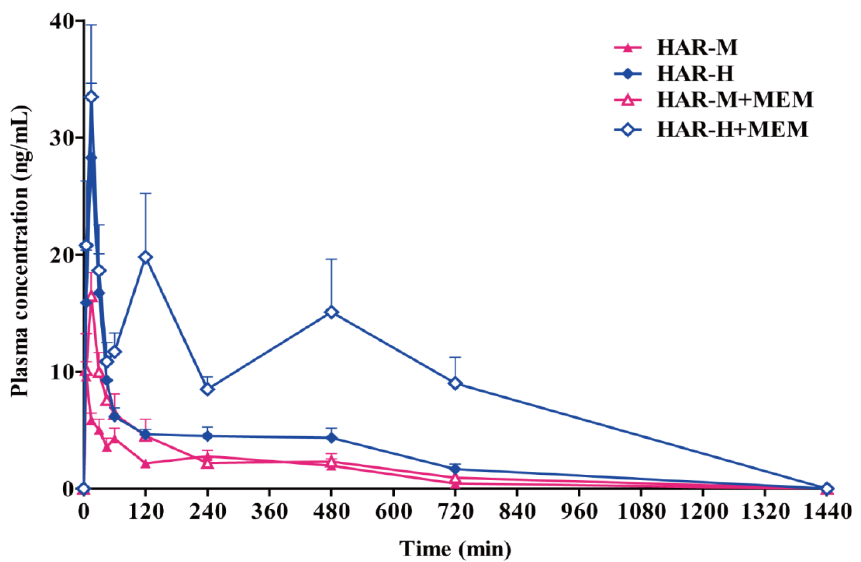
Figure 5. Mean plasma concentration time curves of HOL in rats plasma after oral administration of medium (40.0 mg/kg) and high (80.0 mg/kg) doses of HAR and medium (40.0 mg/kg) and high (80.0 mg/kg) doses of HAR combined with MEM (5.0 mg/kg) (n = 8, mean ± SEM). Table 1. Pharmacokinetics parameters of MEM in rats after single administration of MEM at a dose of 5.0 mg/kg and oral administration of low (20.0 mg/kg), medium (40.0 mg/kg) and high (80.0 mg/kg) doses of HAR combined with MEM (5.0 mg/kg) (n = 8, mean ± SD).